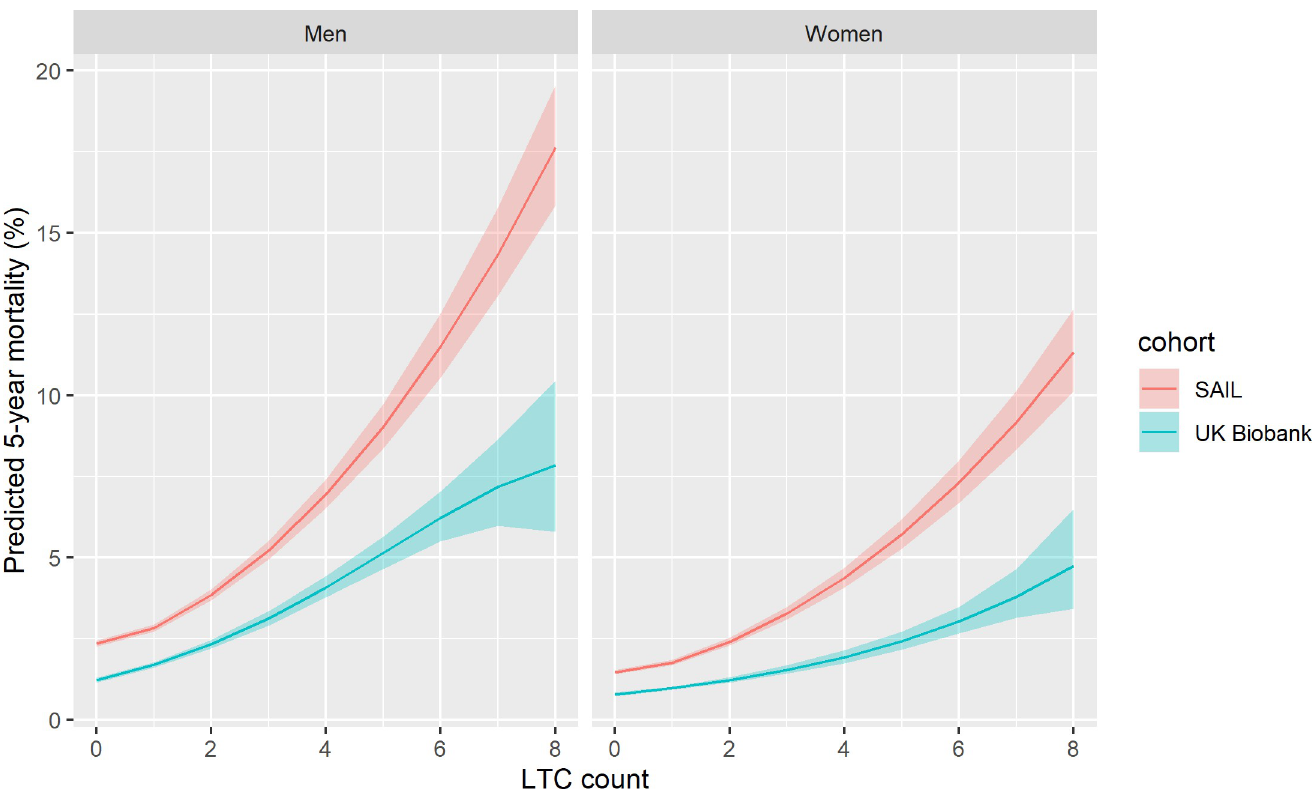
Fig 3. Relationship between LTC count and absolute mortality risk for UK Biobank and SAIL. Lines indicate the modelled 5-year mortality rate. Shaded area indicates 95% confidence interval. Predicted values are modelled at mean age for UK Biobank (56.5 years) and UK national mean Townsend score for socioeconomic status. LTC, long-term condition; SAIL, Secure Anonymised Information Linkage.